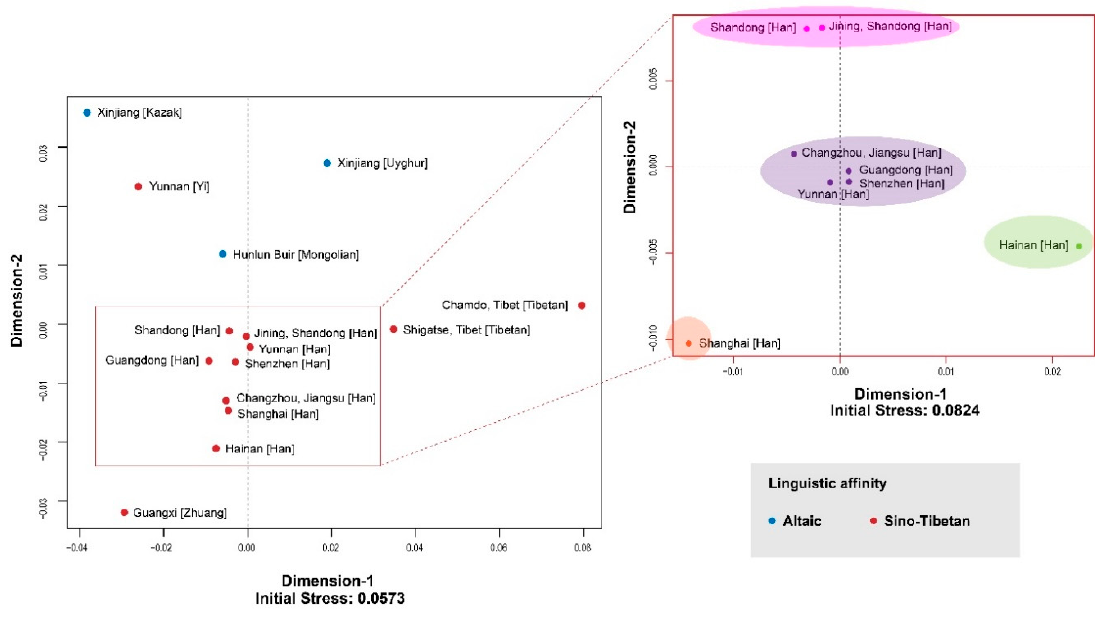
Figure 2. Multidimensional scaling (MDS) plots of 15 Chinese Han populations based on pairwise genetic distances (R ST ). In the left plot, blue dots indicate Altaic-speaking groups, and red dots indicate Sino-Tibetan-speaking populations. In the right plot, Han populations are divided into four clusters which are labeled with various light colors.